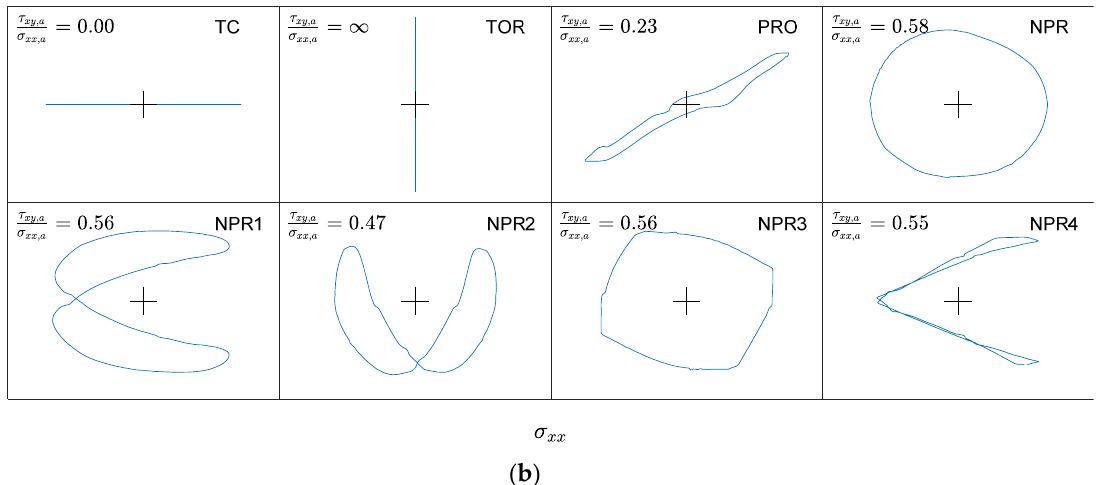
Figure 2. Registered experimental strain paths in ( a ) axial-shear strain space, ε xx − γ xy and ( b ) axial-shear stress space, σ xx − τ xy